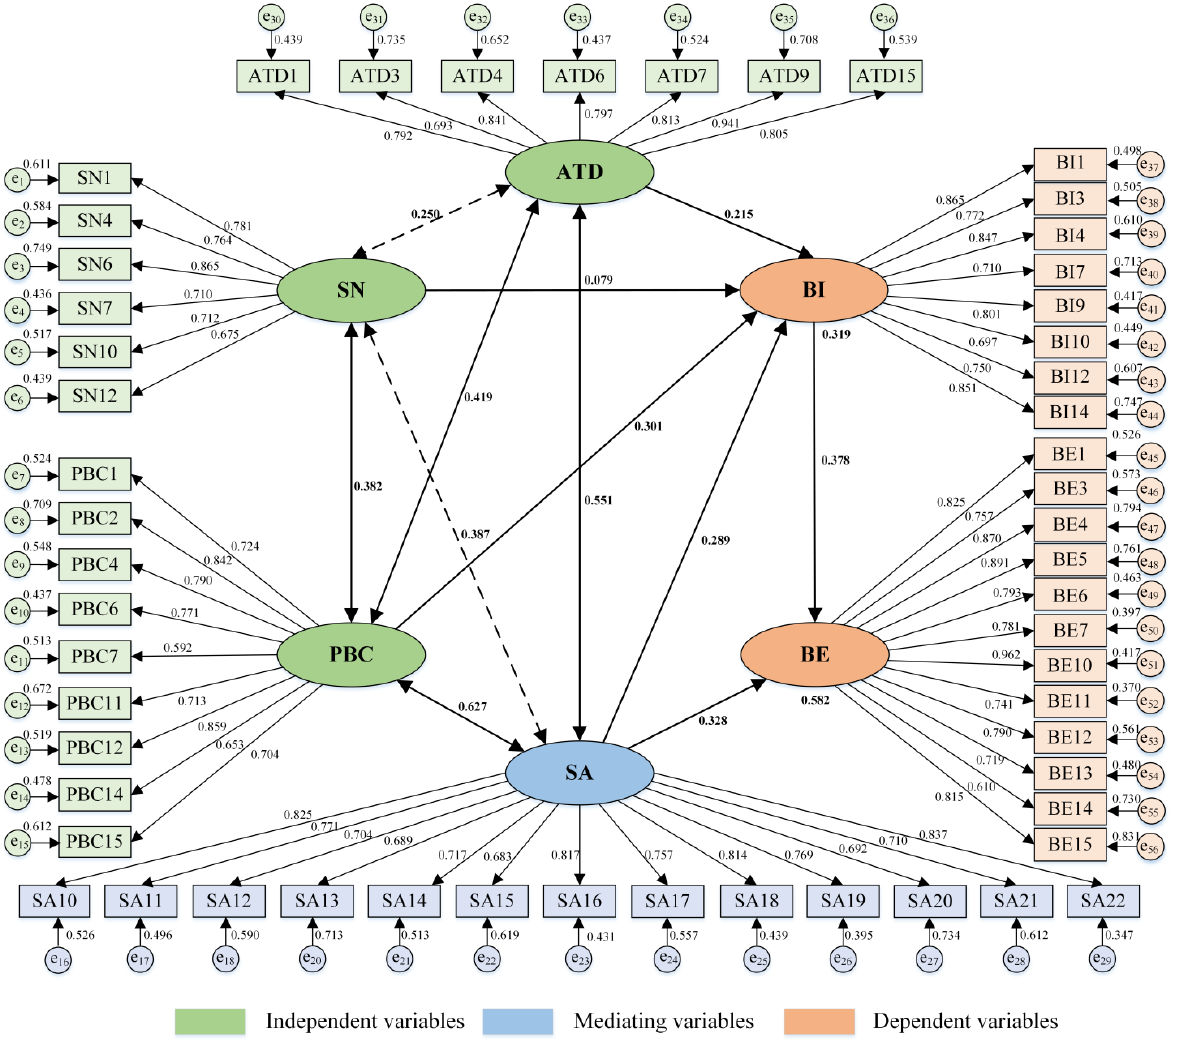
Figure 7. Cognitive path dependency of pilots’ unsafe behaviors.